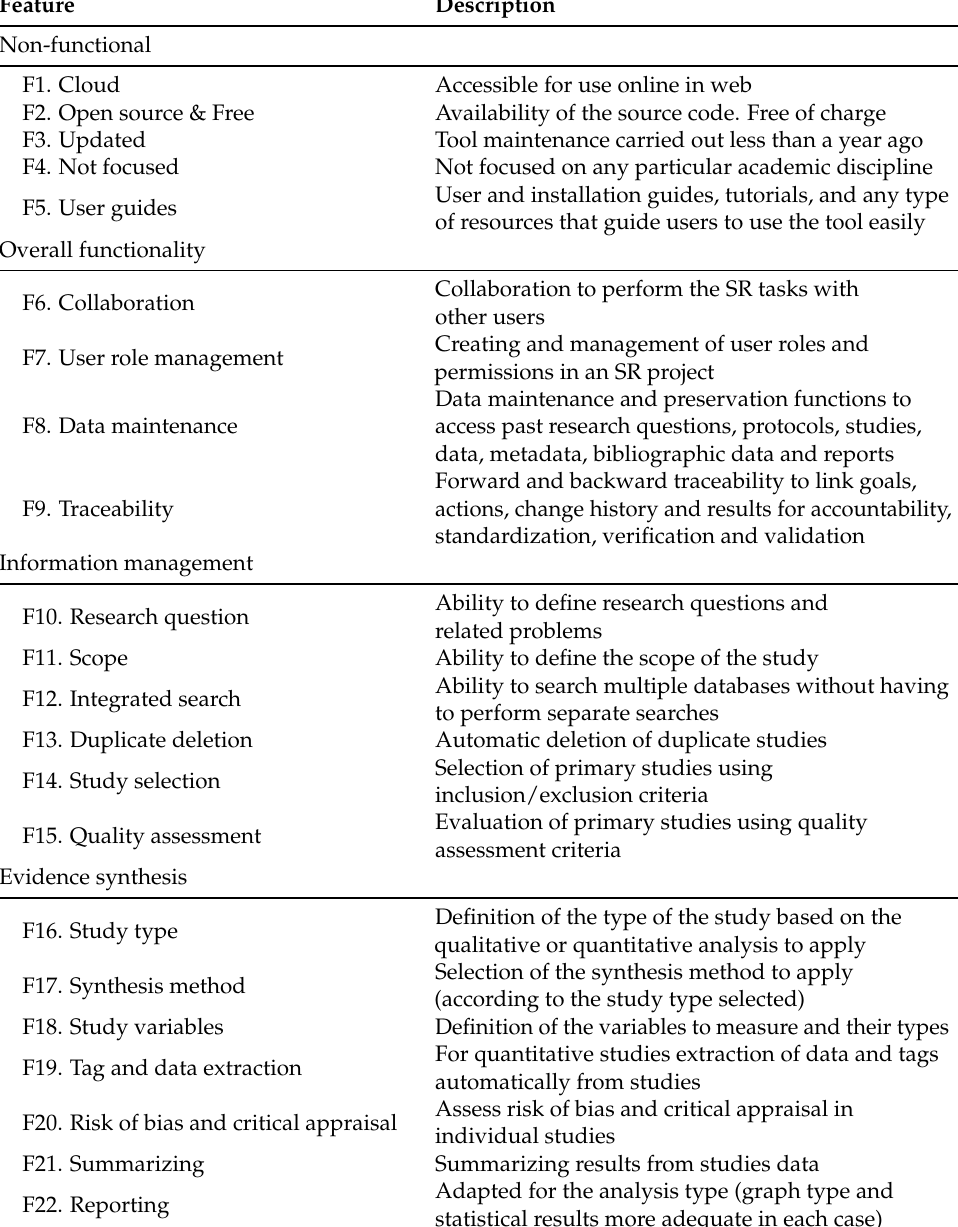
Table 1. Classification of main needed features in SR support